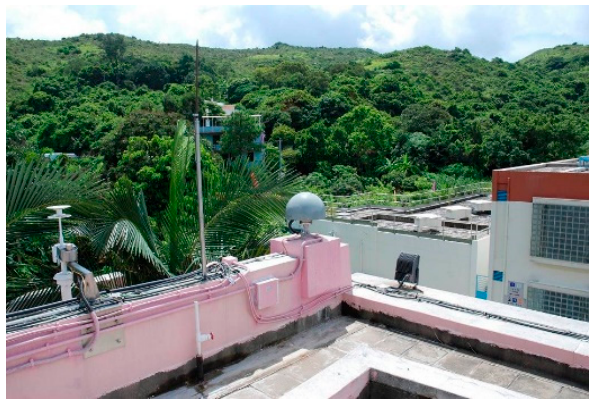
Figure 7. HKLM COSR station.